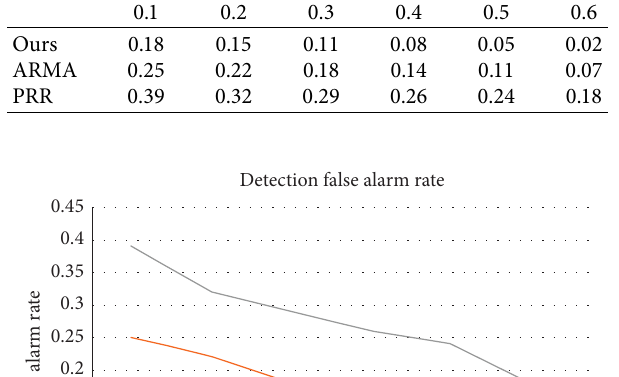
Figure 1: etection accuracy. Table 2: False alarm rates.